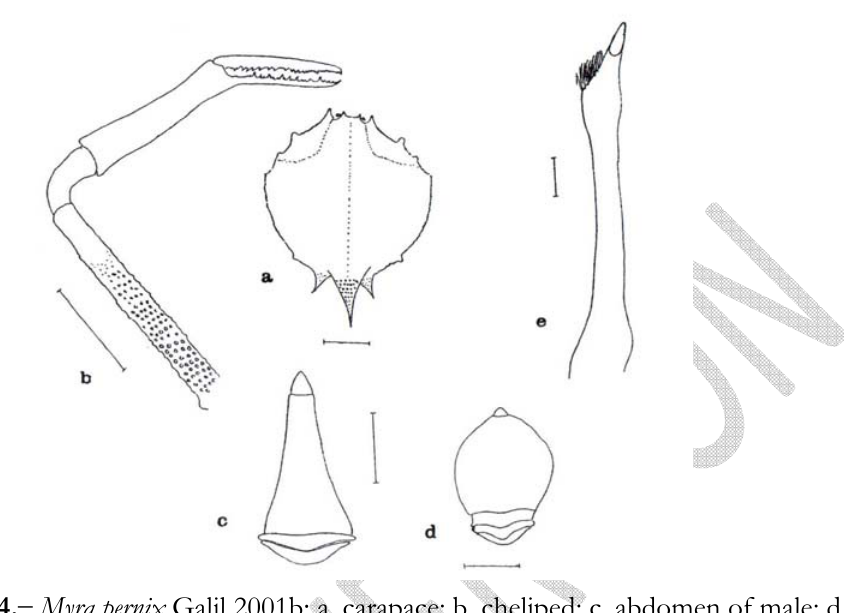
4._ Myra pernix Galil 2001b: a, carapace; b, cheliped; c, abdomen of male; d, F IG . abdomen of female; e, first gonopod. Scales: a, b, c & d, 1 cm; e, 1 mm. Genus Myra Leach, 1817